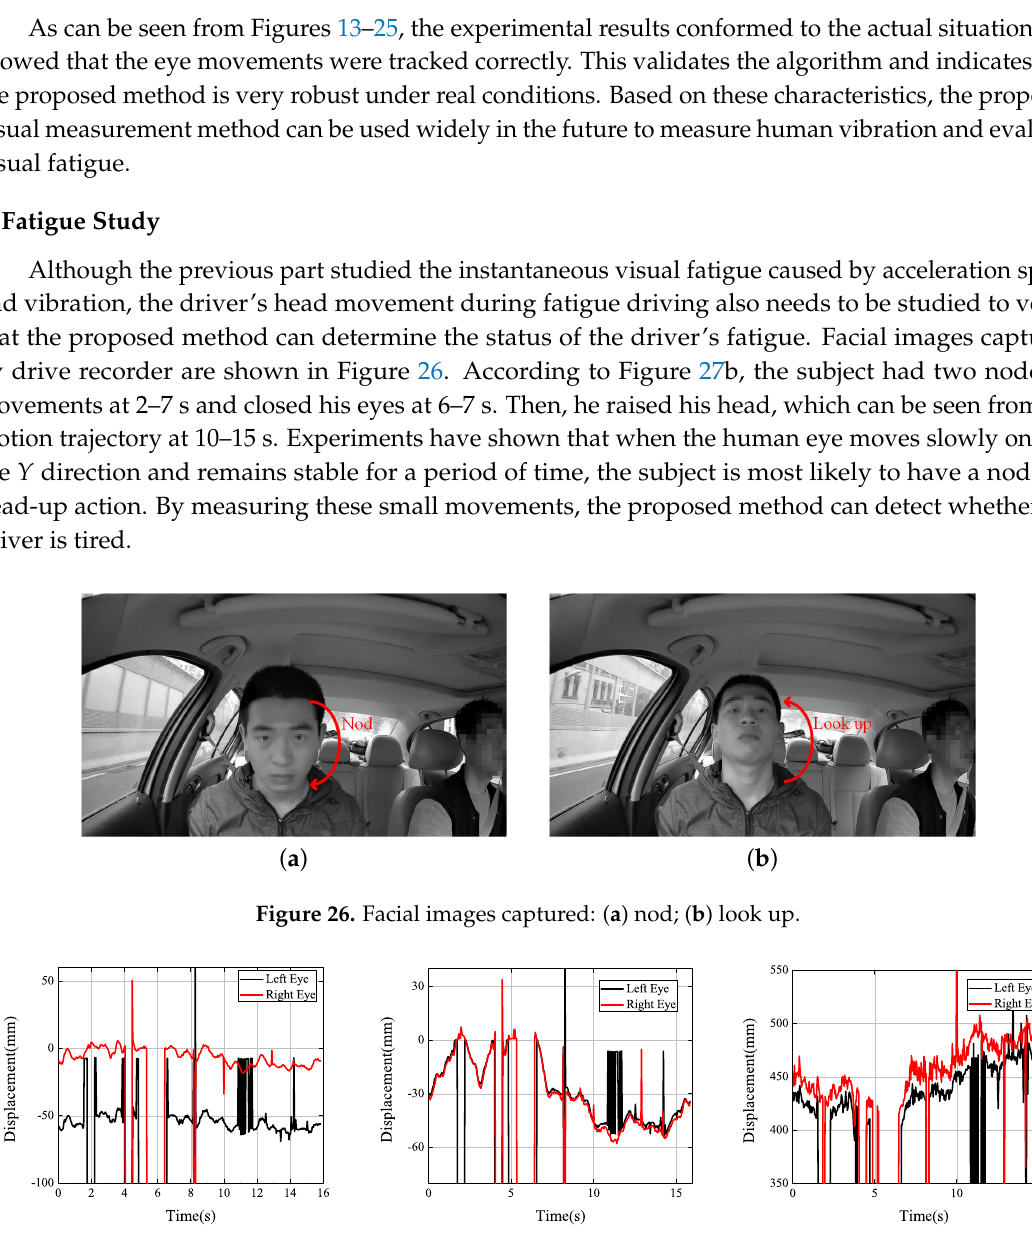
Figure 25. Experimental results obtained: ( a ) X axis; ( b ) Y axis; ( c ) Z axis.